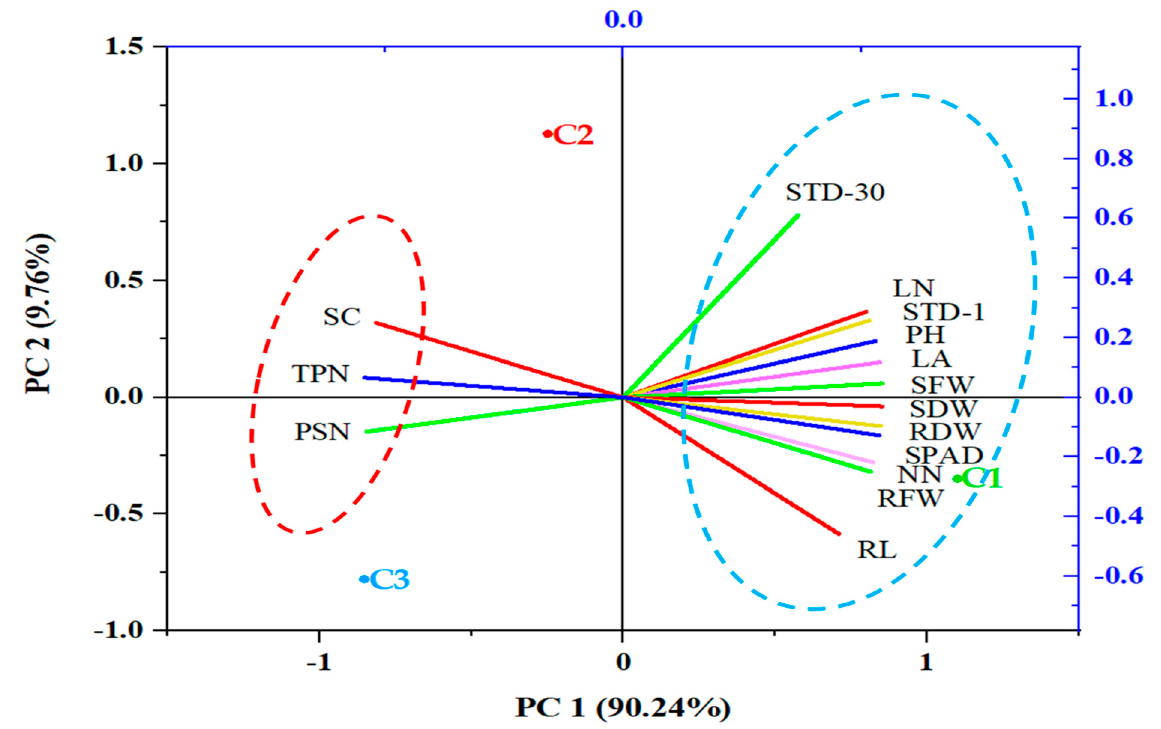
Figure 7. Principal component analysis (PCA) illustrates the variable treatment relationships among the three treatments of M-9 apple rootstock plant at 11 weeks after in a greenhouse. C1, C2 and C3 indicate container sizes of 1000 mL, 500 mL and 300 mL, respectively. The lines starting from the central point of the biplots display the negative or positive associations of the different variables, and their proximity specifies the degree of correlation with specific treatment. PH, plant height; LN, leaf number; LA, leaf area; NN, node number; RL, root length; STD-1, stem diameter from 1 cm of ground; STD-30, stem diameter from 30 cm of ground; SFW, shoot fresh weight; RFW, root fresh weight; SDW, shoot dry weight; RDW, root dry weight; SPAD, SPAD value; PSN, photosynthesis rate; SC, stomatal conductance and TPN, transpiration rate.